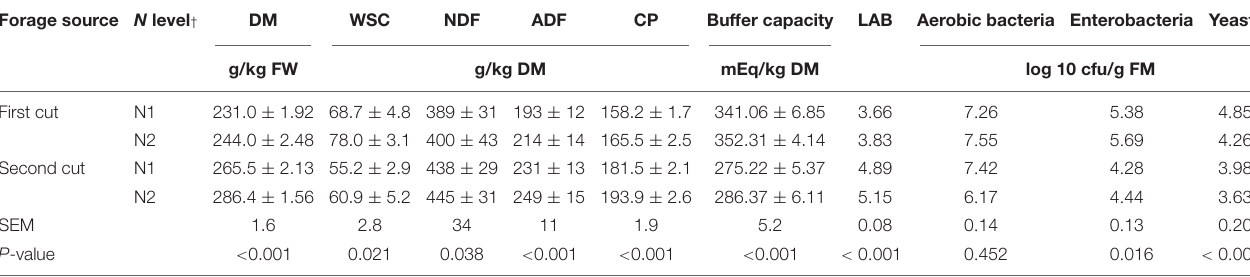
TABLE 1 | Chemical composition and microbial population of fresh forage mulberry.